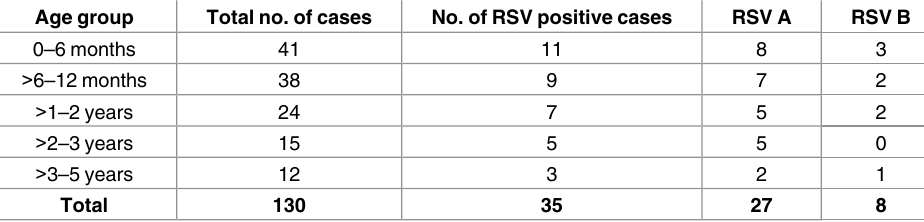
Table 2. Age wise distribution of the RSV positive